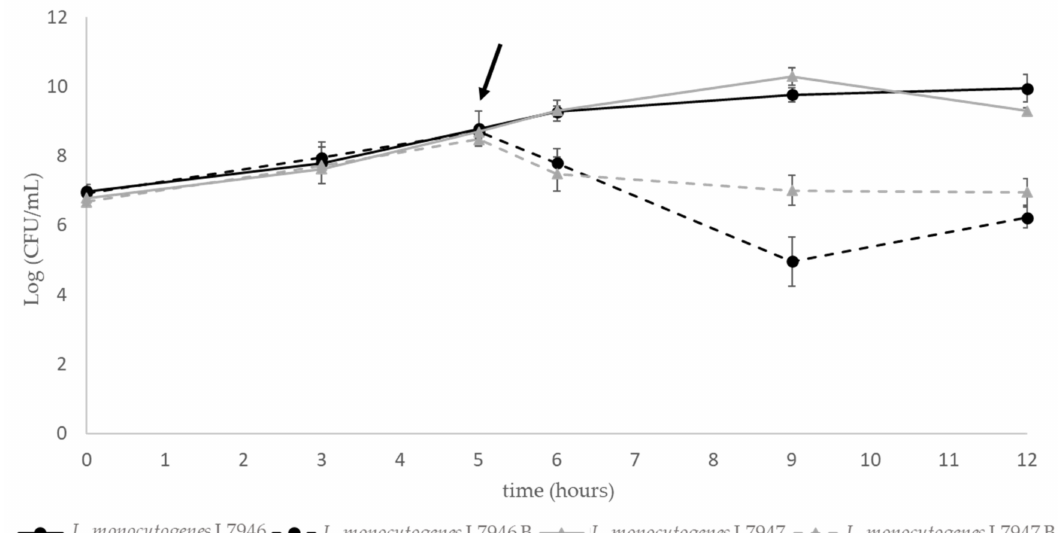
Figure 3. Effect of R23 bacteriocin(s) on the growth of L. monocytogenes L9746 (dotted black lines) and L. monocytogenes L7947 (dotted grey lines) presented as log (CFU/mL). The continuous line represents target cultures without added bacteriocins. The arrow indicates the point at which the bacteriocin-containing CFS was